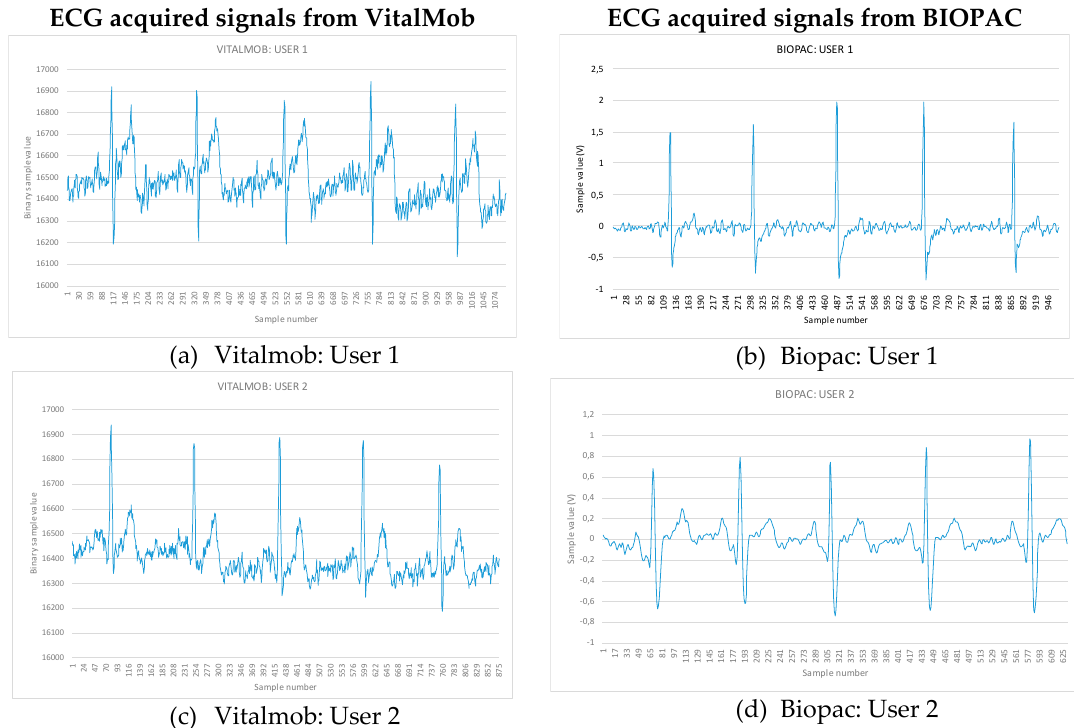
Figure 7. VitalMob and Biopac ECG samples